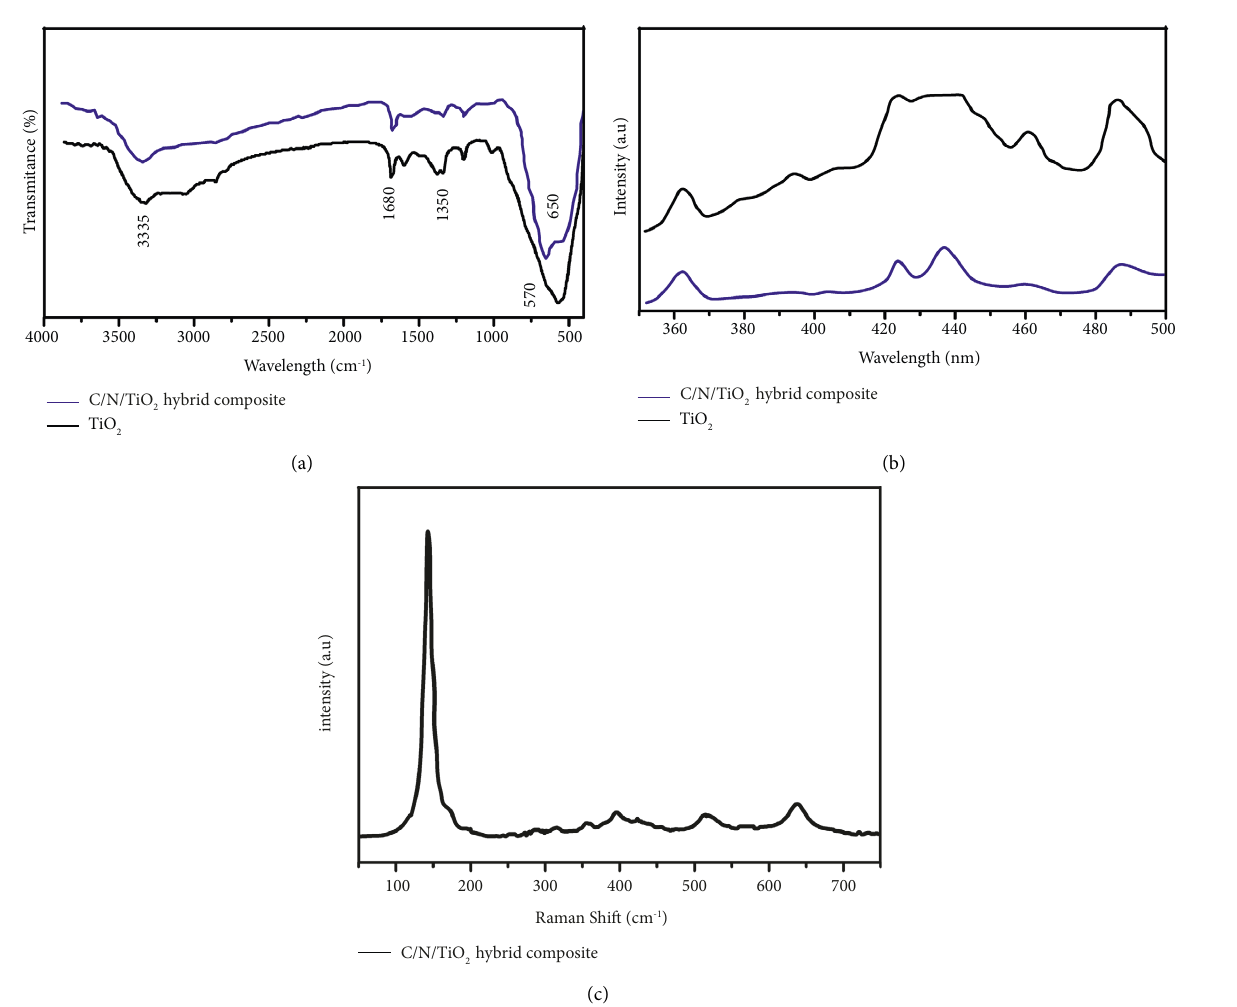
Figure 3: (a) FTIR. (b) Photoluminescence. (c) Raman spectra of pure TiO